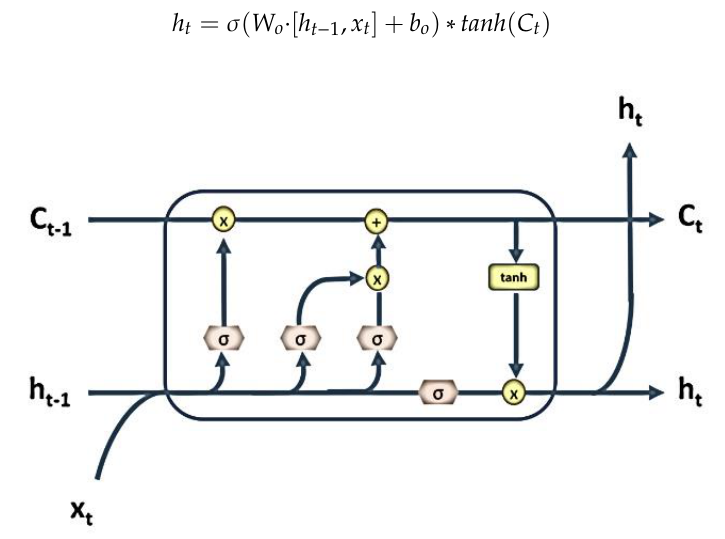
Figure 3. The basic long short-term (LSTM) unit.